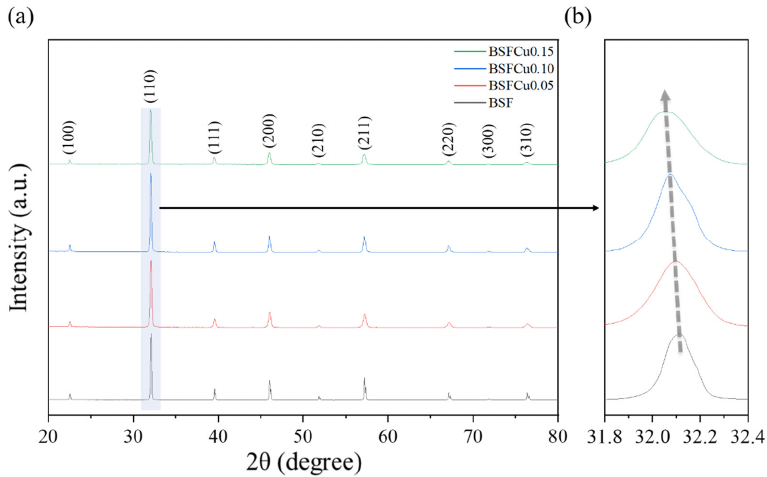
Figure 1. ( a ) Room temperature PXRD patterns of the Ba 0 . 5 Sr 0 . 5 Fe 1-x Cu x O 3−δ (x = 0, 0.05, 0.10, 0.15). ( b ) Enlarged (110) peaks.